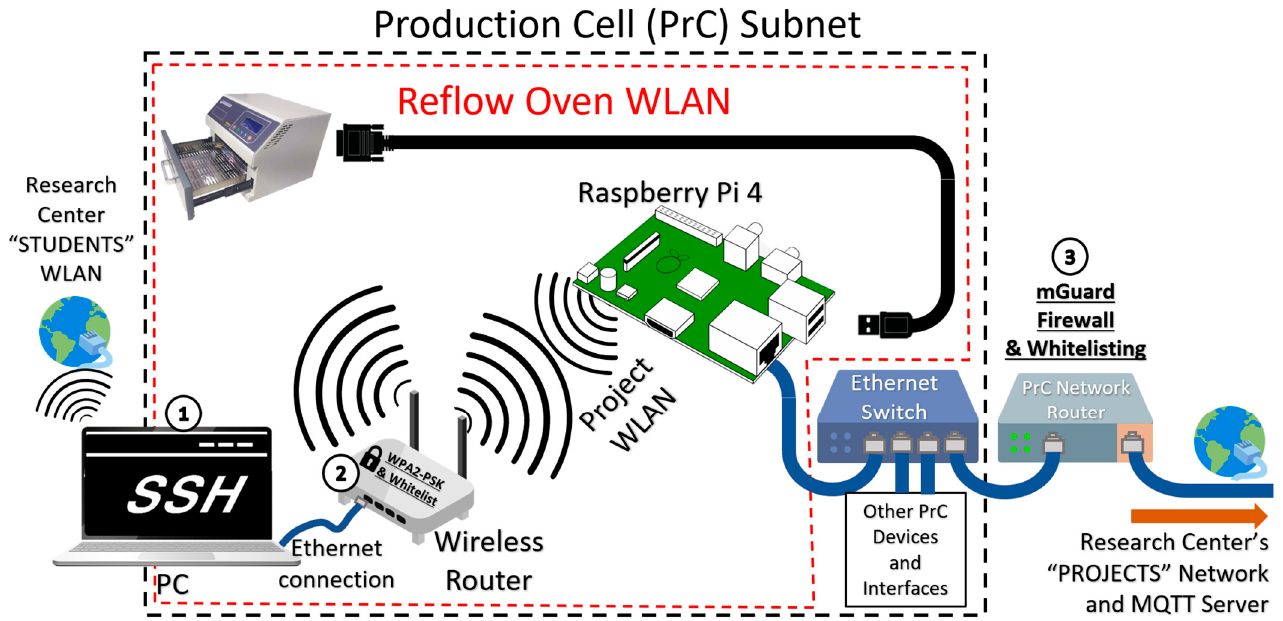
Figure 7. Labels 1–3 indicate the three different implemented strategies of cybersecurity: (1) Maintain data traffic from possibly “unclean devices” away from the reflow oven’s WLAN, by utilizing different NICs. (2) The wireless router managing the reflow oven WLAN follows the WPA2-PSK Security Standard and operates under a Whitelist. (3) The PrC Subnet is managed by a Phoenix mGuard Router, which runs the mGuard Firewall and enforces yet another Whitelist.